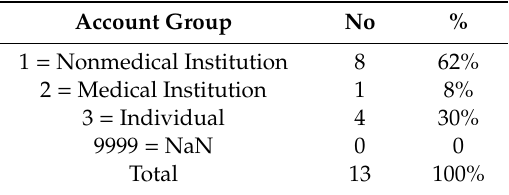
Table A1. The account group that an article comes from.